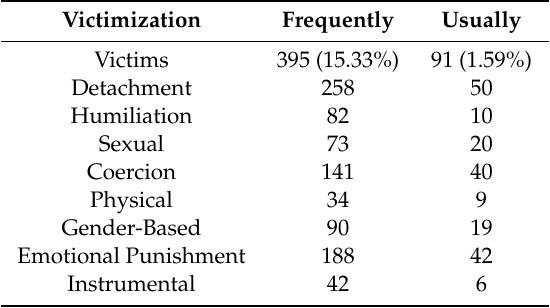
Table 3. Frequency and modalities of victimization.